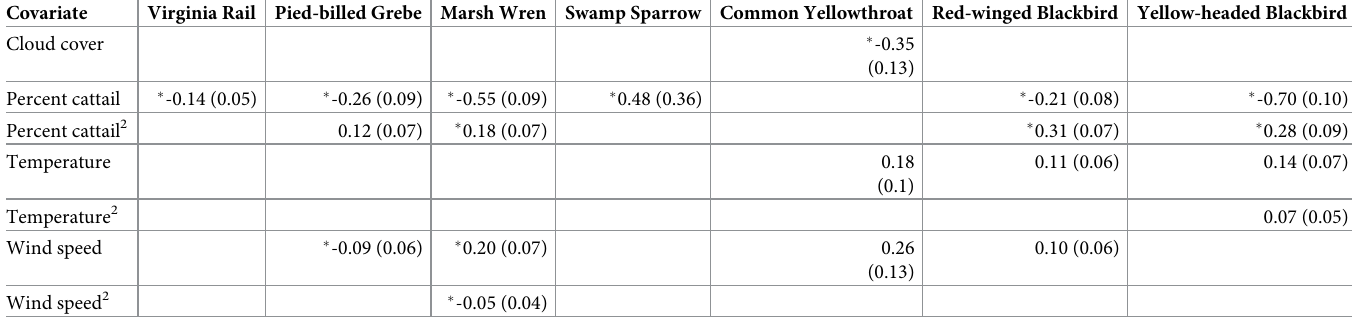
Significant ( P < 0.05) beta coefficients are indicated with an asterisk ( �